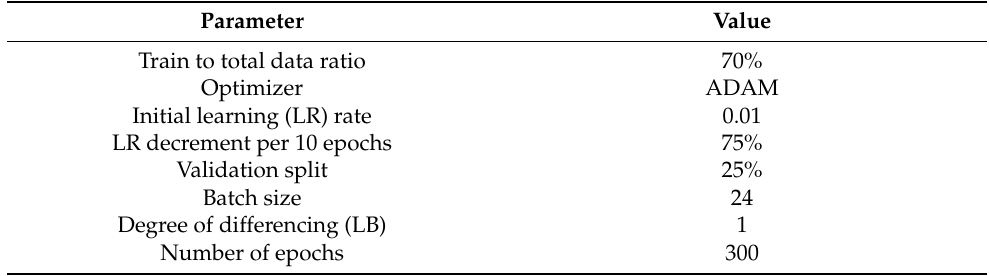
Table 3. Tuned hypermeters and model inputs for the parameter prediction in hour span with LSTM.